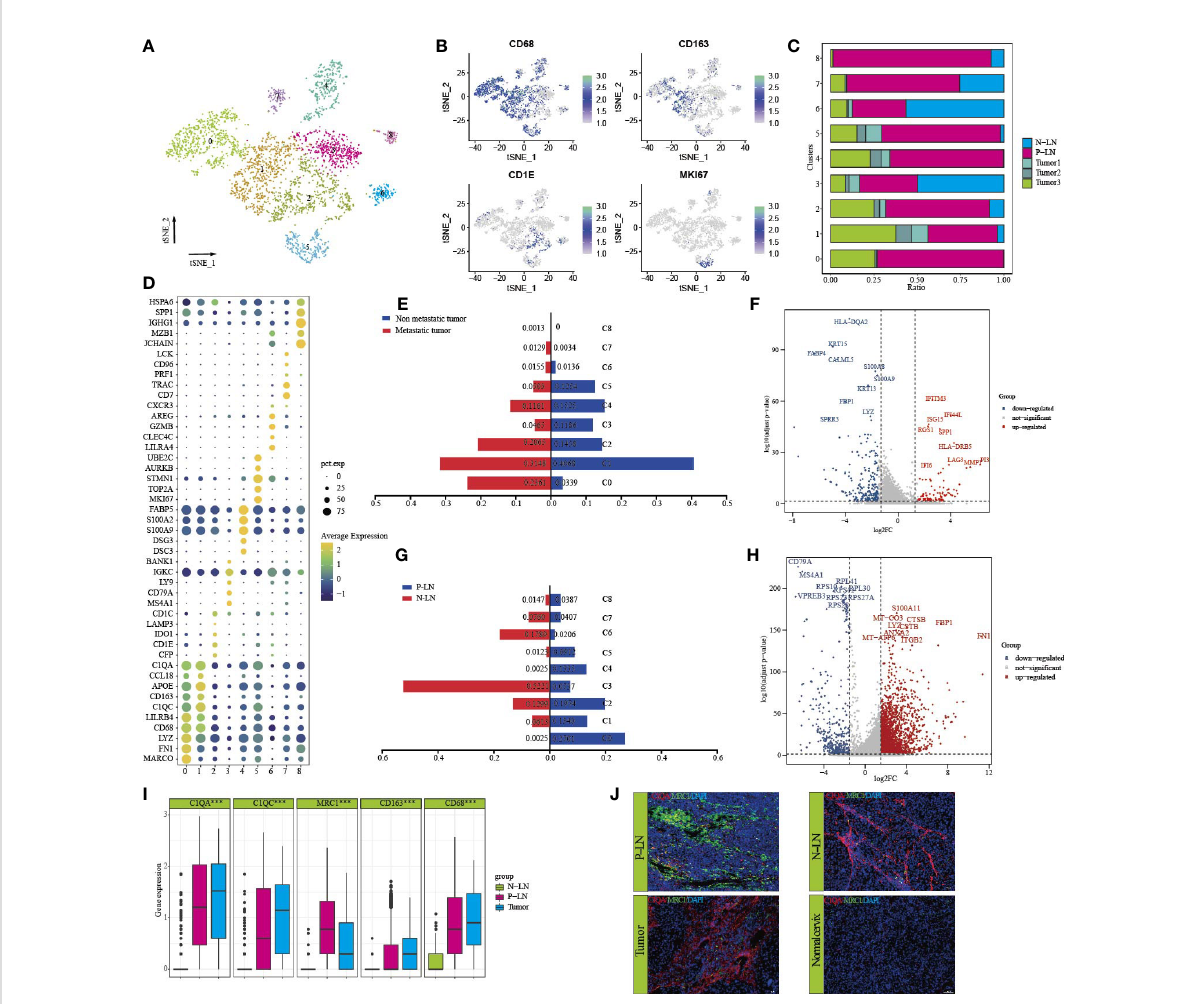
FIGURE 4 Characteristics of macrophages in primary tumor and metastatic lymph node. tSNE of macrophages, with each cell color-coded for nine clusters of all cells (C0 – C8) (A) . tSNE of marker genes for each cluster (B) . The proportion of each sample in nine clusters (C) . Dot plot of signi fi cant representative genes in nine clusters (D) . The difference in each cluster proportion of macrophages between metastatic tumors (tumor 3) and non-metastatic tumors (tumors 1 and 2) (E) . Volcano plot showing differentially expressed genes of macrophages between metastatic tumor (tumor 3) and non-metastatic tumors (tumors 1 and 2) (F) . The difference of each cluster proportion of macrophages between P-LN and N-LN (G) . Volcano plot showing differentially expressed genes of macrophages between P-LN and N-LN (H) . Bar plots showing the expression of C1QA, C1QC, MRC1, CD163, and CD68 in P-LN, N-LN, and primary tumor (*** p < 0.001) (I) . Immuno fl uorescence staining of signi fi cant markers in P-LN, N-LN, primary tumor, and adjacent normal tissue blue = DAPI, green = MRC1, red = C1QA (J)